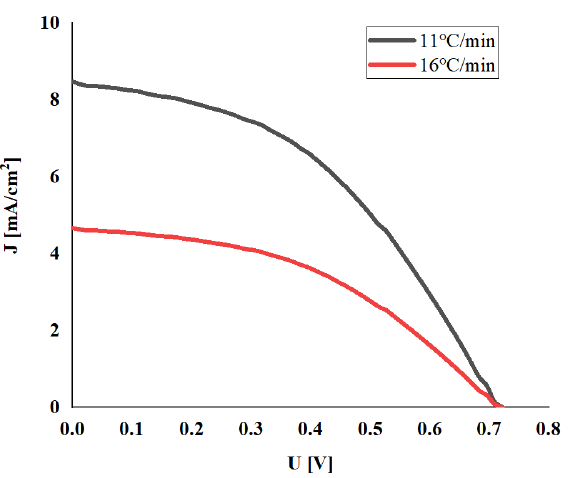
Figure 5. J–V Characteristics of DSSC with TiO 2 film prepared at different heating rates.